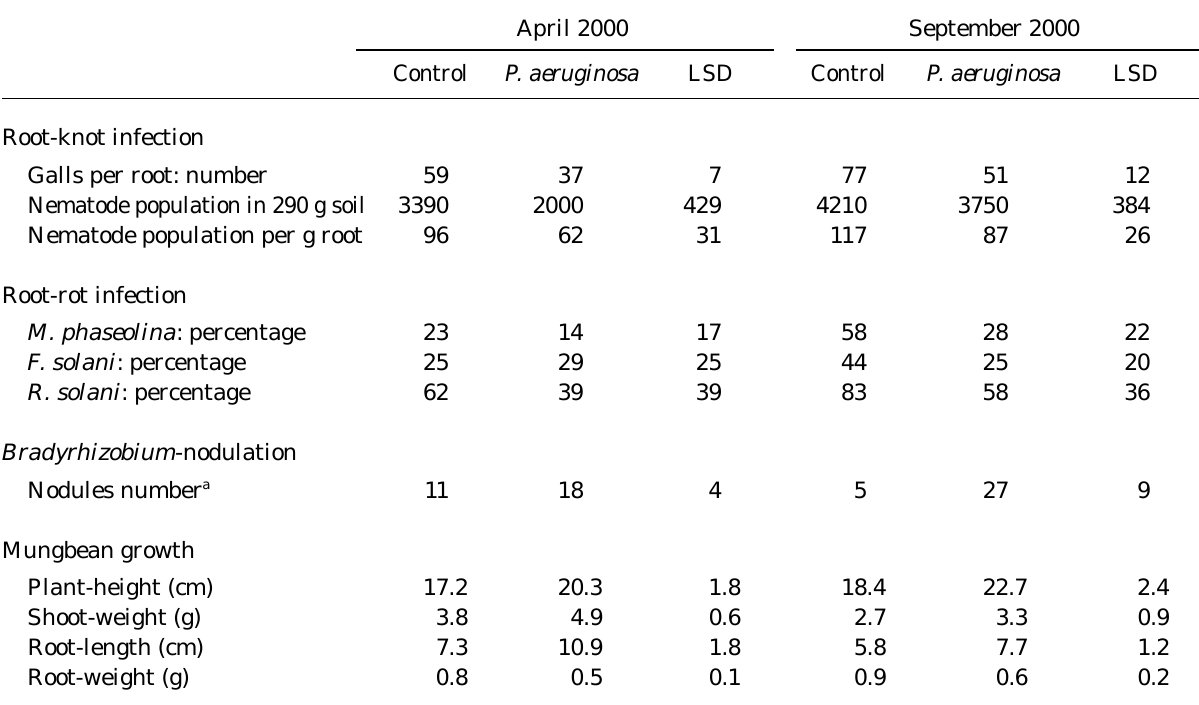
Table 2. Effects of seed treatment with talc powder-carboxymethyl cellulose based inoculum of Pseudomonas aeru- ginosa strain-78 on root-knot and root-rot infection by various fungi, Bradyrhizobium nodulation and growth